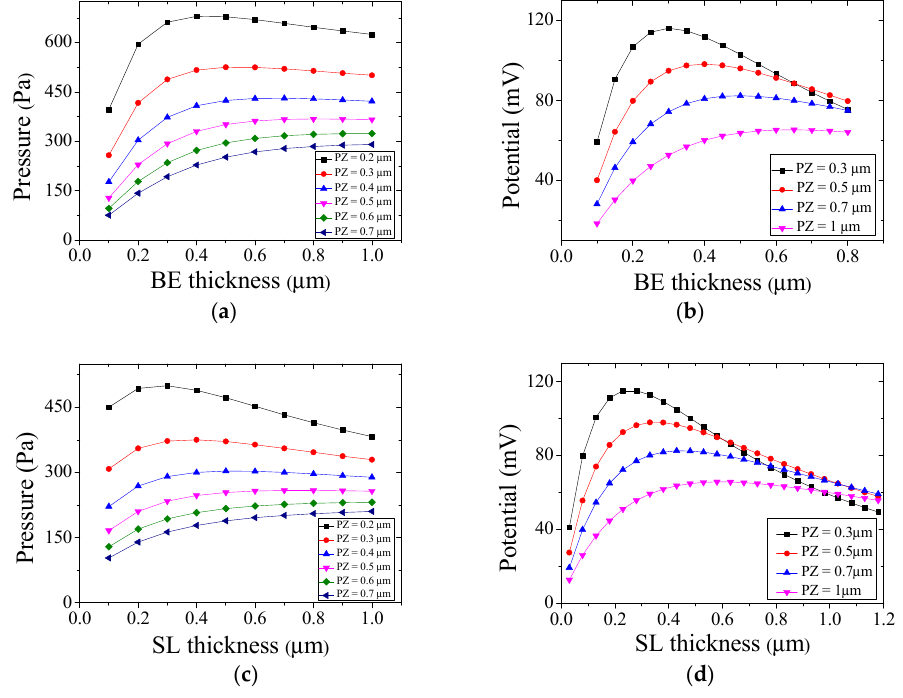
Figure 3. ( a ) Surface pressure under 1 V pp driving voltage at the resonant frequency. ( b ) Electrical potential under 100 Pa as a function of piezoelectric layer/bottom electrode (PZ/BE) thickness ratio, with the seed layer (SL) thickness fixed at 50 nm. ( c , d ) The surface pressure and the electrical potential under various PZ/SL thickness ratios when the BE thickness is fixed at 100 nm.